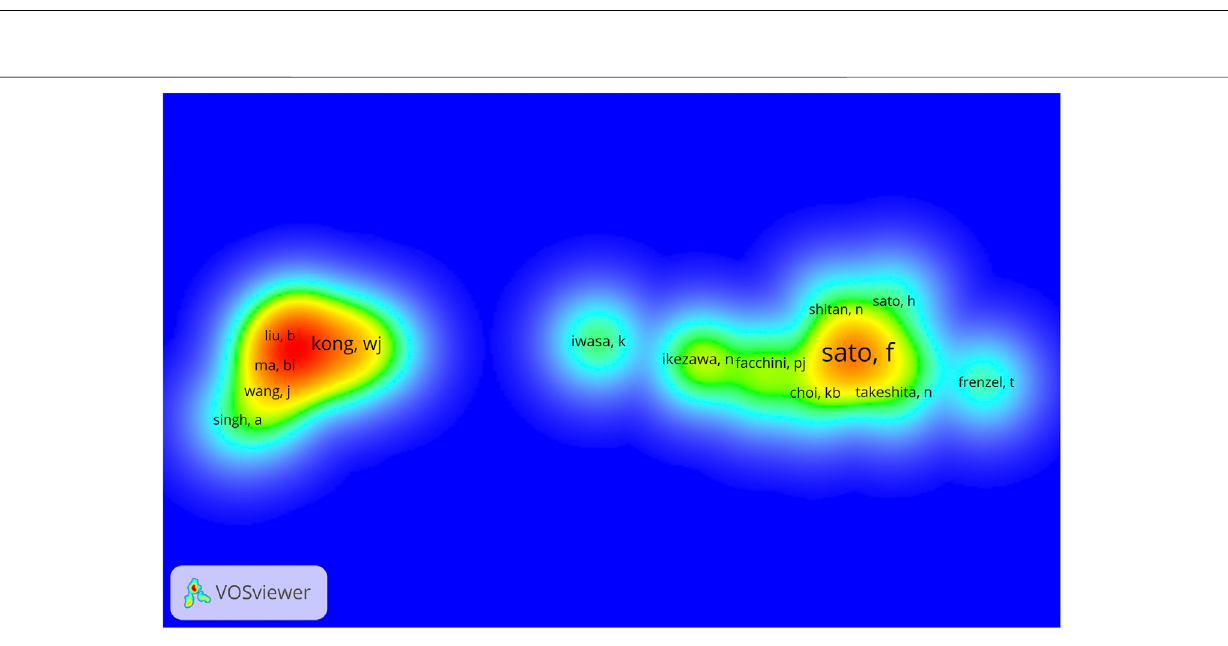
FIGURE 6 | Cluster density view of the author co-citation analysis of Coptis research.